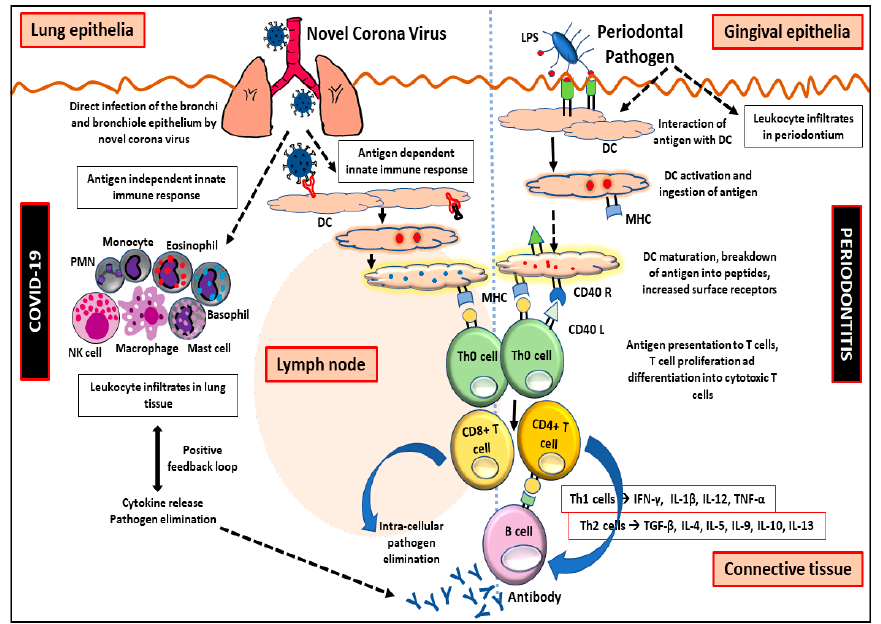
Figure 4. Immune-pathogenetic similarities and cytokine interplay in periodontitis and COVID-19. Lastly, bacterio-viral interactions diminish respiratory ciliary activity and enhance bacterial adhesion, which facilitate pathogenic aspiration from oral cavities [58]. Table 3 shows that the occurrence of periodontitis is associated with COVID-19 and COVID-19 worsens the severity of periodontal disease and COVID-19-related hospitalization. Therefore, periodontal disease management and a decreased pathogenic load may decrease the accidental aspiration of periodontal pathogens into the lungs and decrease hospitalization or COVID-19-related complications [59]. Table 3. Data showing association between periodontitis and COVID-19 and if periodontitis worsens COVID-19 severity .